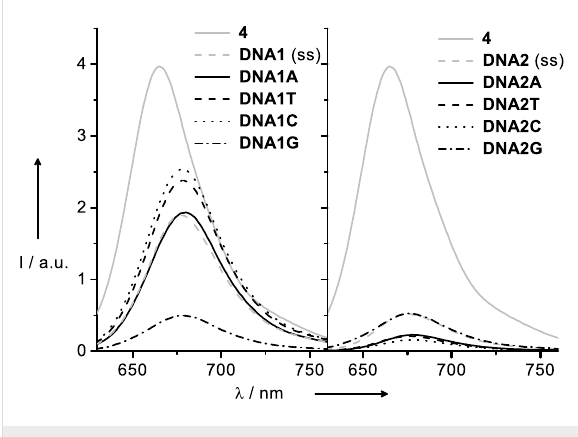
Figure 2: Fluorescence spectra of single-stranded DNA1 and DNA2 , and corresponding duplexes DNA1Y and DNA2Y (2.5 μM) in sodium phosphate buffer (10mM) of pH 7.0, NaCl (250 mM), λ exc = 610